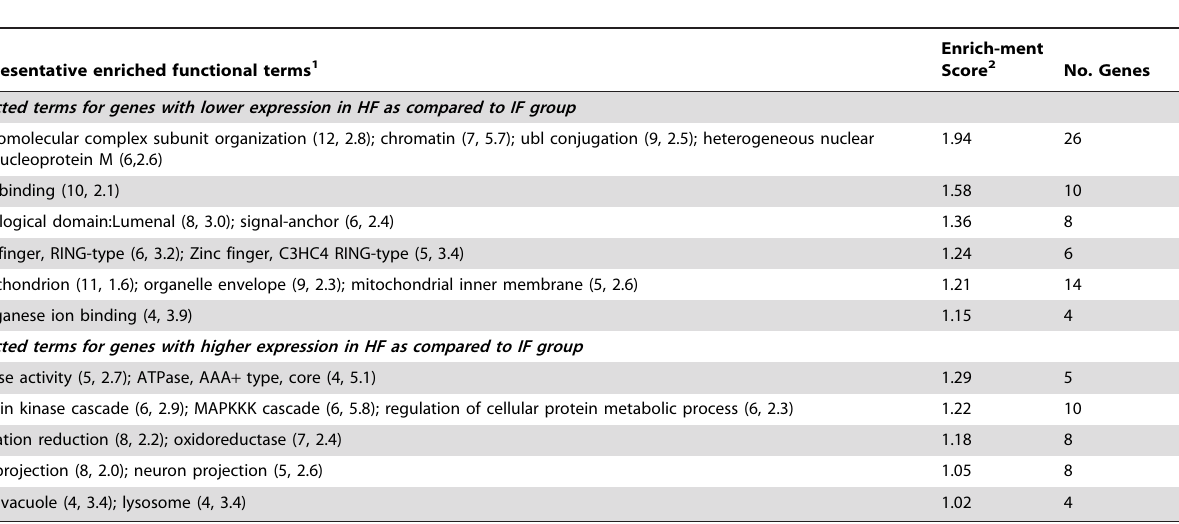
Table 3. Selected overrepresented functional categories for differentially expressed genes in High Fertile as compared to Infertile heifers (nominal P-value ,